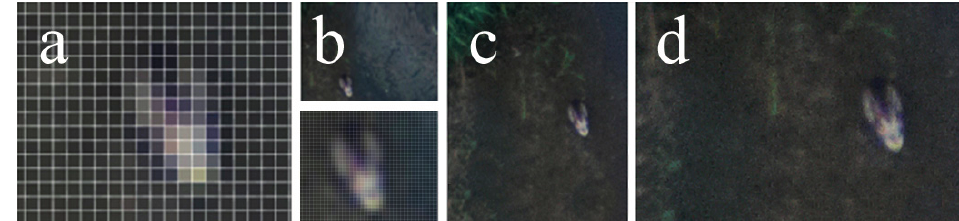
Figure 10. Ortho image map section showing ( a ) a mallard at the 7 cm spatial resolution (enlarged); ( b ) a mallard at the 5 cm spatial resolution; ( c ) a mallard at the 2.5 cm spatial resolution; and ( d ) a mallard at the 1 cm spatial resolution.